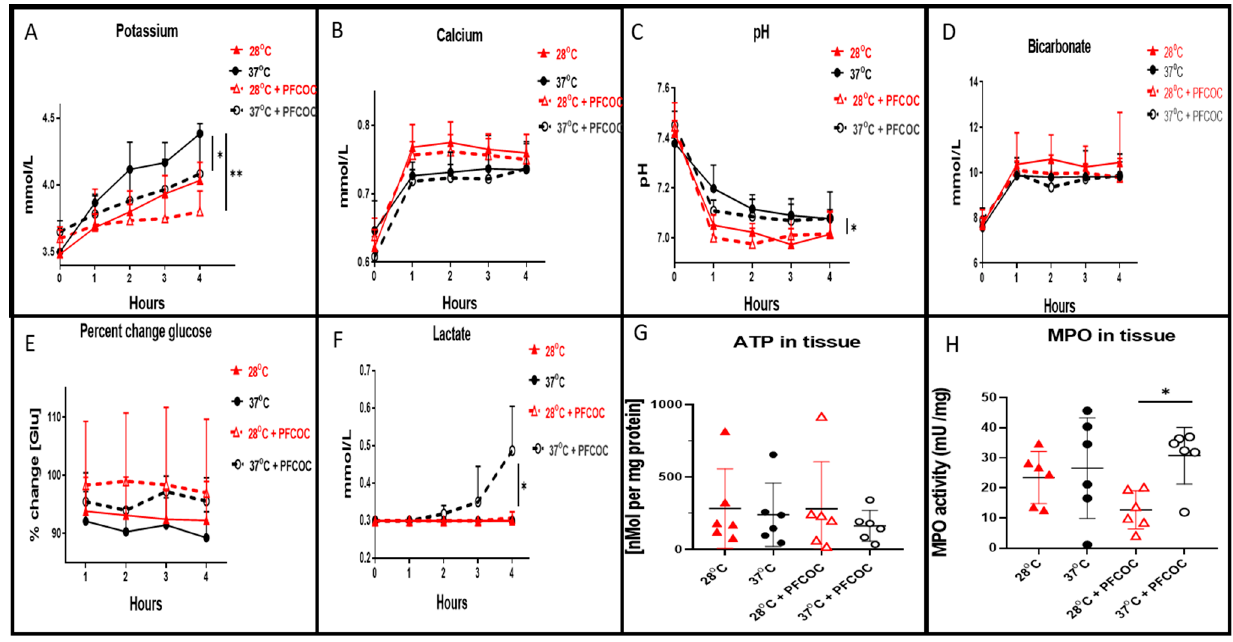
Figure 2. Perfusate clinical biochemistry, ATP and MPO tissue levels. ( A ). During EVLP at 37 ◦ C we recorded significantly increased potassium levels in perfusates when compared to EVLP at 28 ◦ C (* p < 0.05) and also potassium at 37 ◦ C was increased in comparison to the perfusates of EVLP at 28 ◦ C with PFCOC (** p < 0.01). ( B ). Calcium level in EVLP perfusates at 37 ◦ C +/ − PFCOC were lower but were not statistically lower when compared to calcium perfusate levels after EVLP done at 28 ◦ C +/ − PFCOC. ( C ). The pH recorded in the 28 ◦ C +/ − PFCOC EVLP perfusates were significantly lower than the 37 ◦ C +/ − PFCOC (* p < 0.05). ( D ). Levels of bicarbonate were lower at 37 ◦ C +/ − PFCOC EVLP although not significantly lower than the 28 ◦ C +/ − PFCOC EVLP. ( E ). Percent change of glucose from baseline showed higher levels remaining in the perfusates during the EVLP done with PFCOC at 28 ◦ C or 37 ◦ C. ( F ). Lactate levels in the 37 ◦ C + PFCOC EVLP perfusates were significantly increased versus all the other conditions (* p < 0.05). ( G ). ATP content of lung tissues after the 28 ◦ C EVLP with or without PFCOC were higher but not significantly different from the lung tissues after the 37 ◦ C EVLP with or without PFCOC conditions. ( H ). MPO lung tissue activities were significantly increased in the 37 ◦ C with PFCOC group when compared to the 28 ◦ C with PFCOC group (* p <